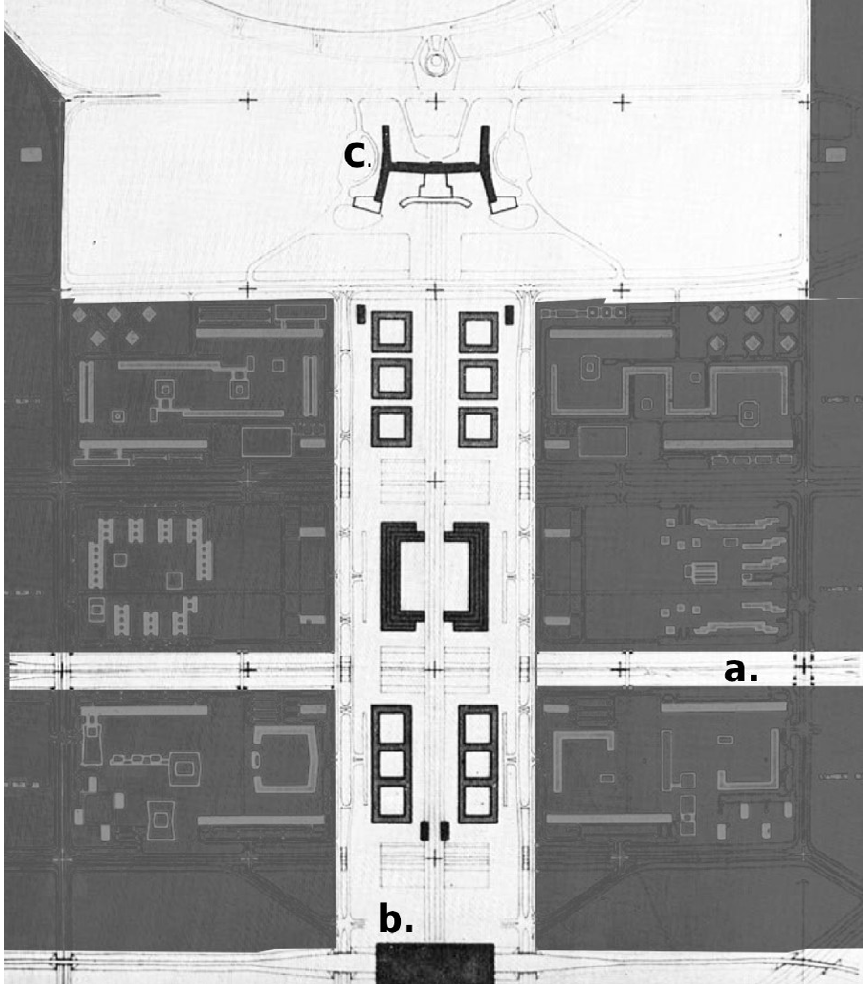
Fig. 8 Caption: Map of Novi Beograd showing the intersection between the Highway (a), the railway (b) and the central axis stemming from the Federation Palace